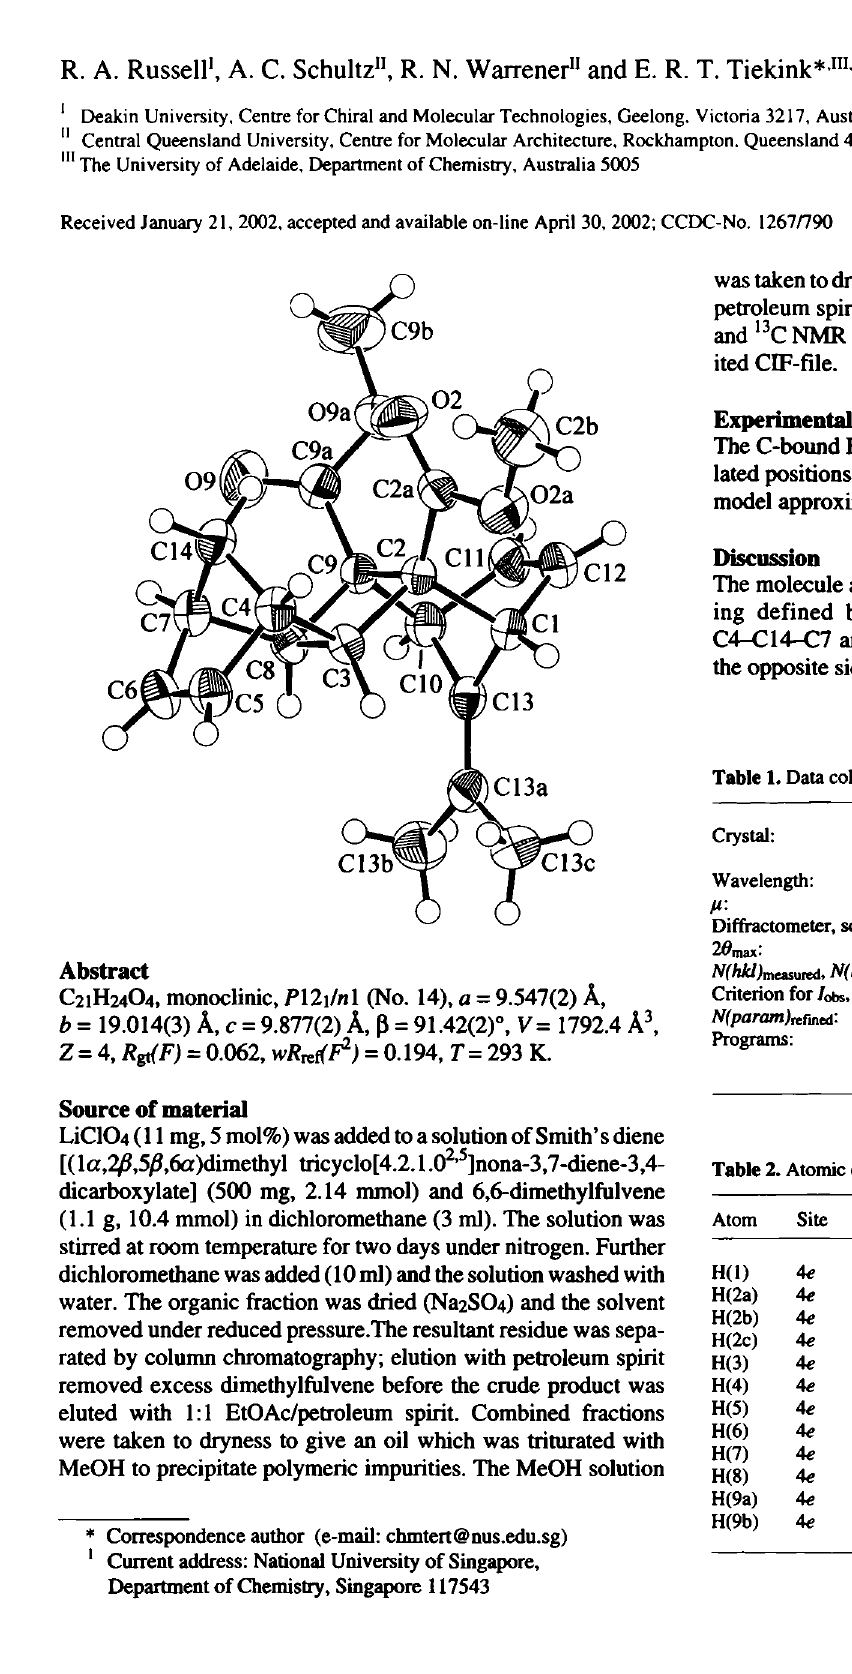
Table 1. Data collection and handling.